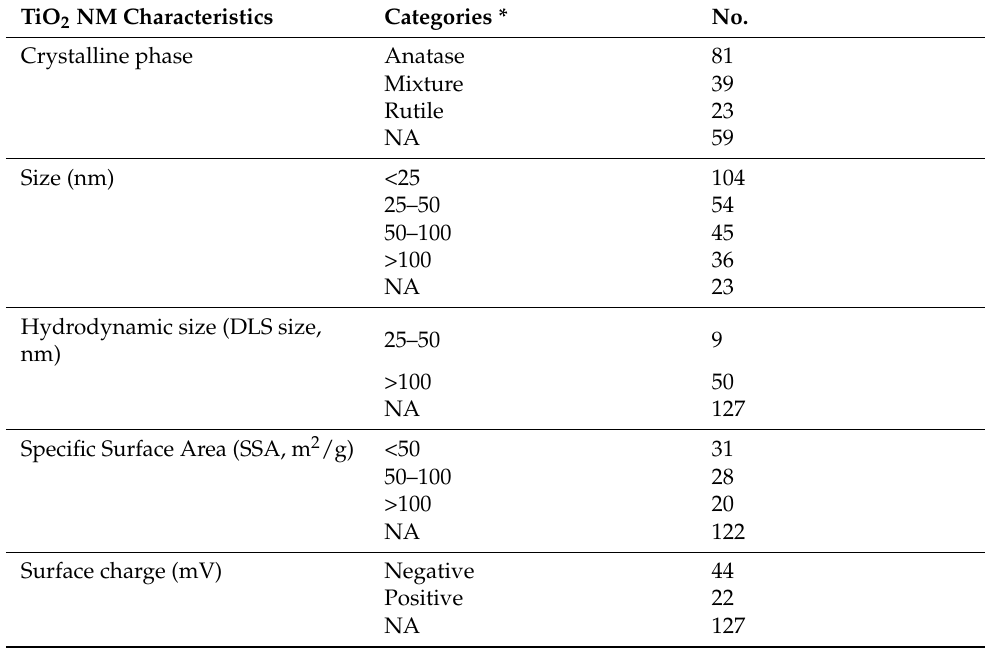
Table 1. TiO 2 -NPs physicochemical parameters among the selected 185